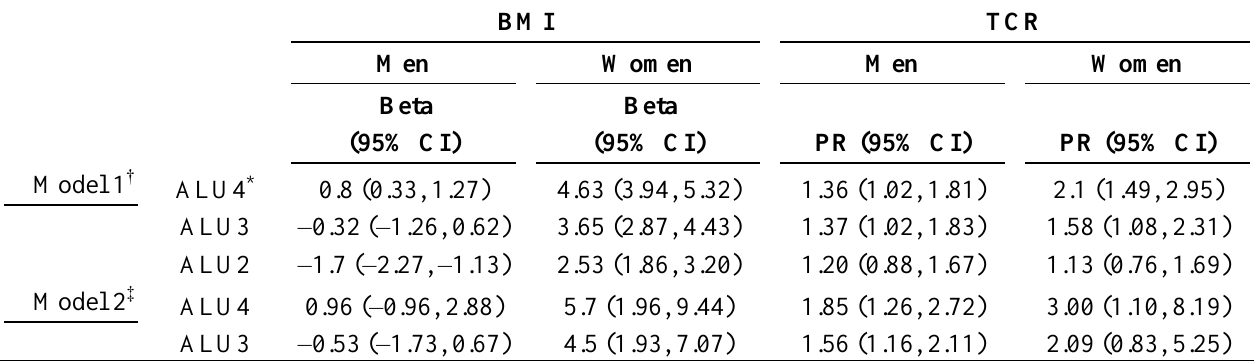
Table 4. Association between area-level unemployment (ALU), body mass index (BMI) and total cardiometabolic risk (TCR) for 169 men and 173